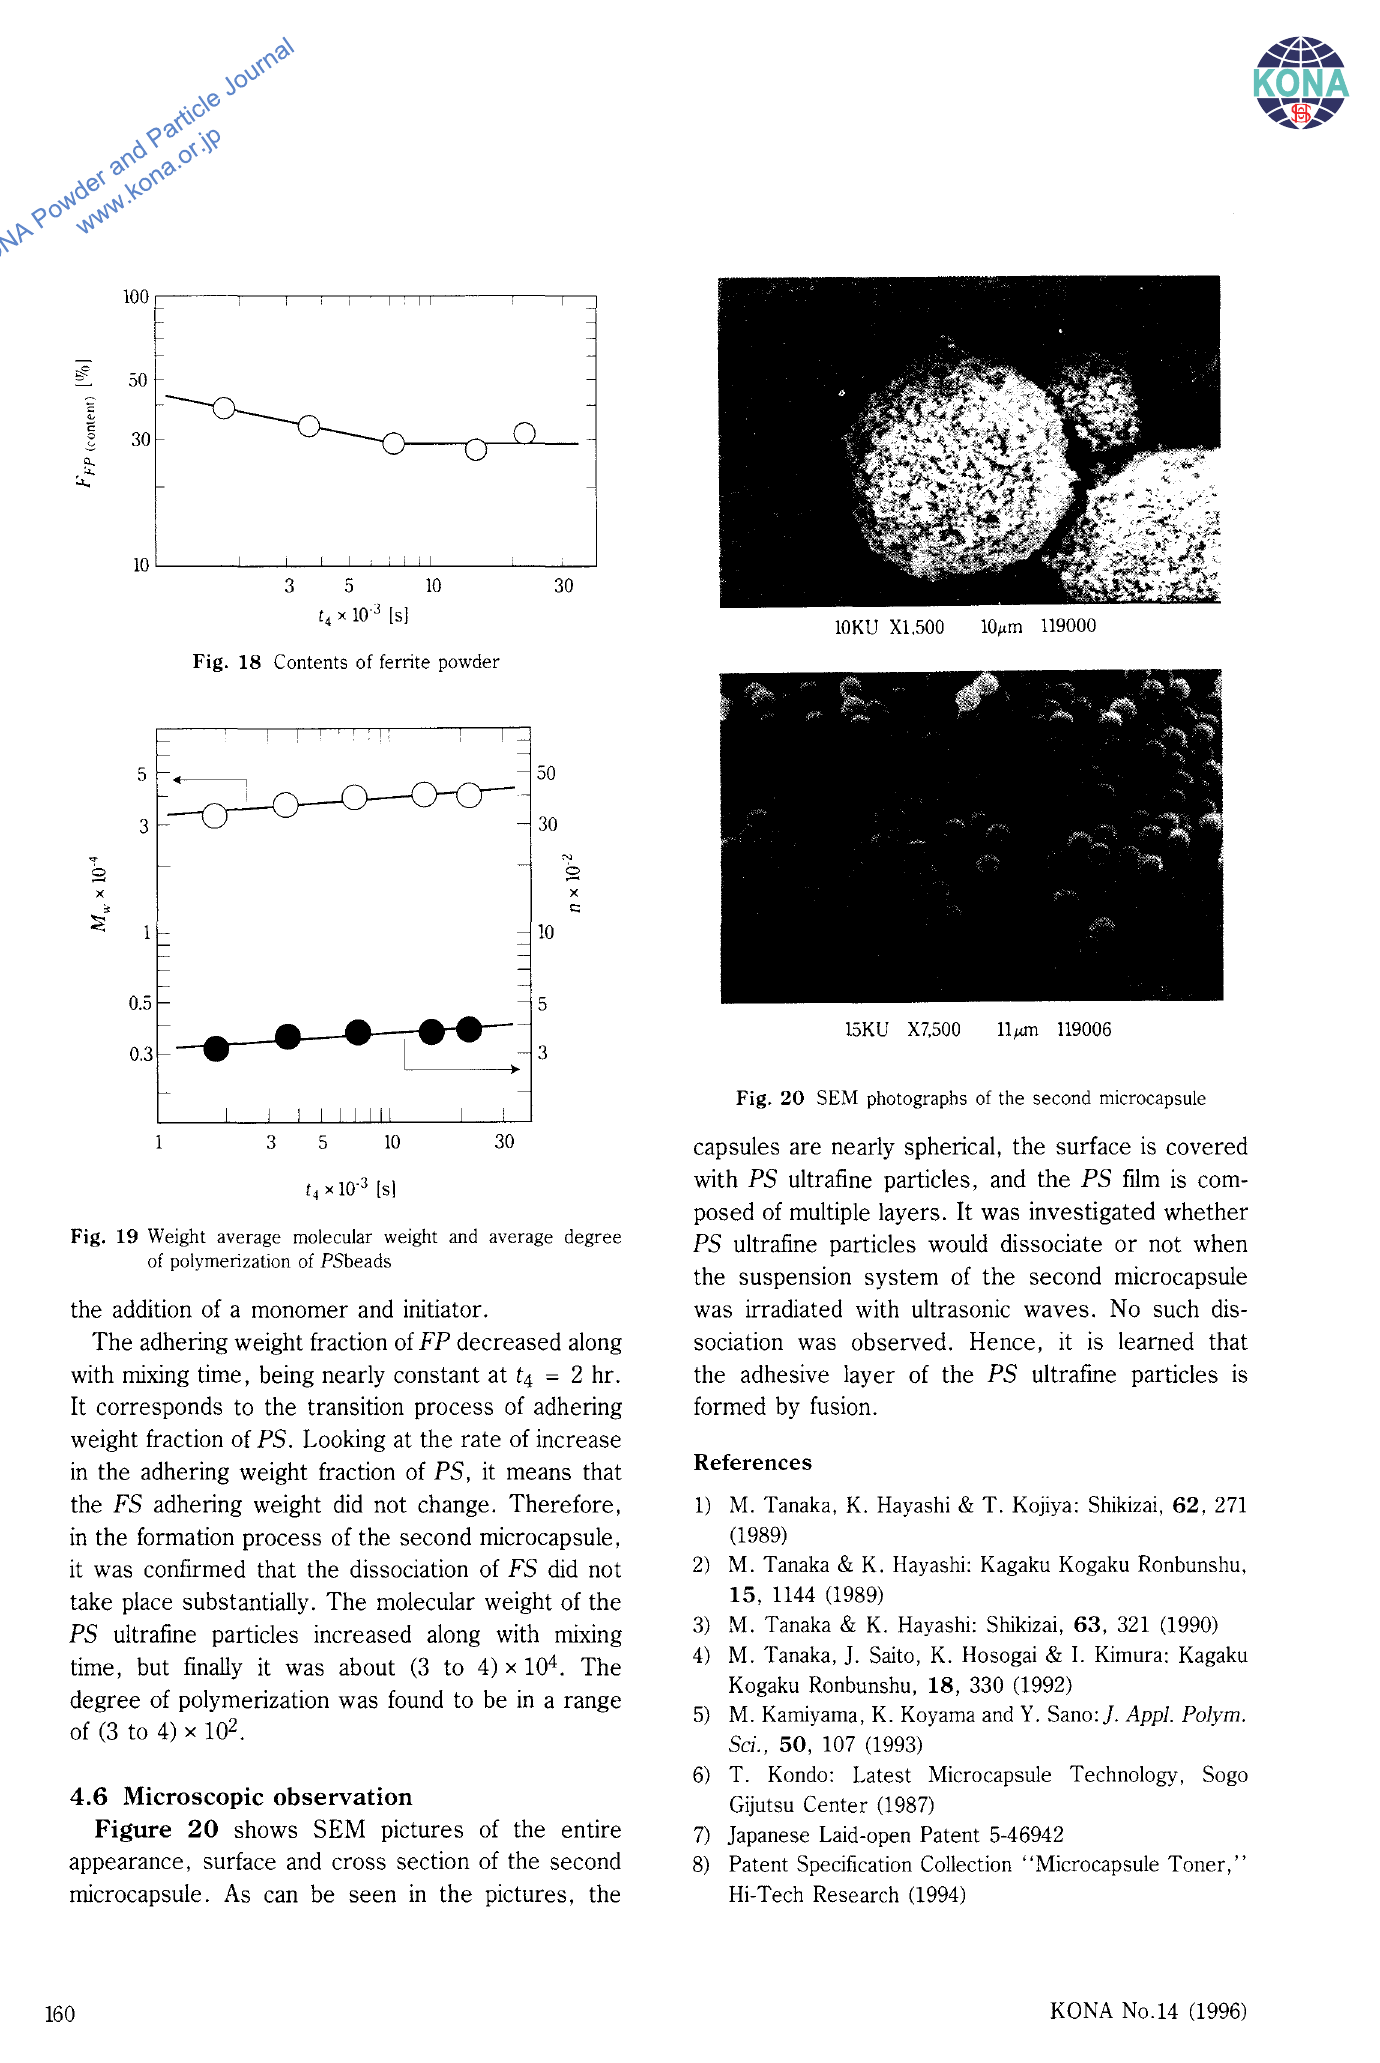
Fig. 19 Weight average molecular weight and average degree of polymerization of PSbeads the addition of a monomer and initiator.